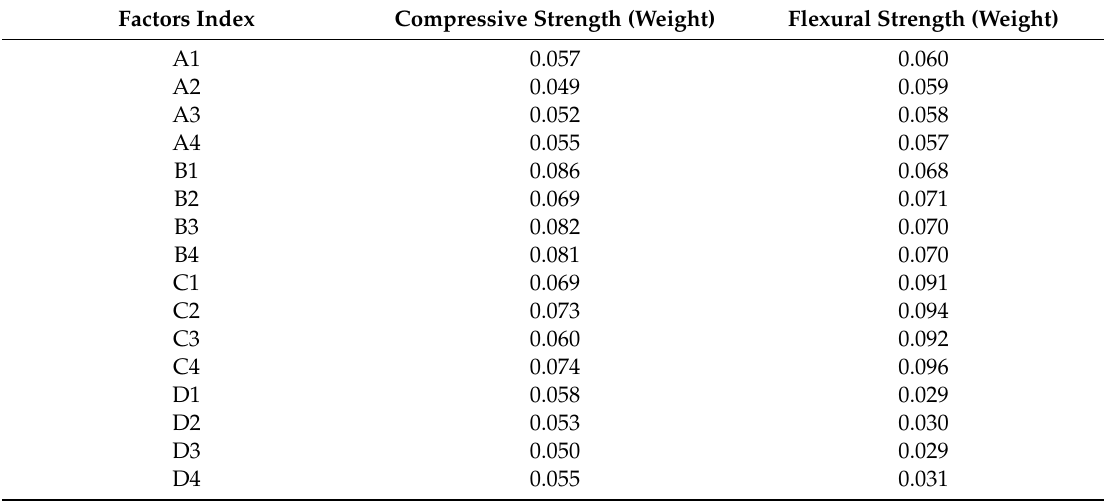
Table 7. Weight of Each Factors Influence on Each